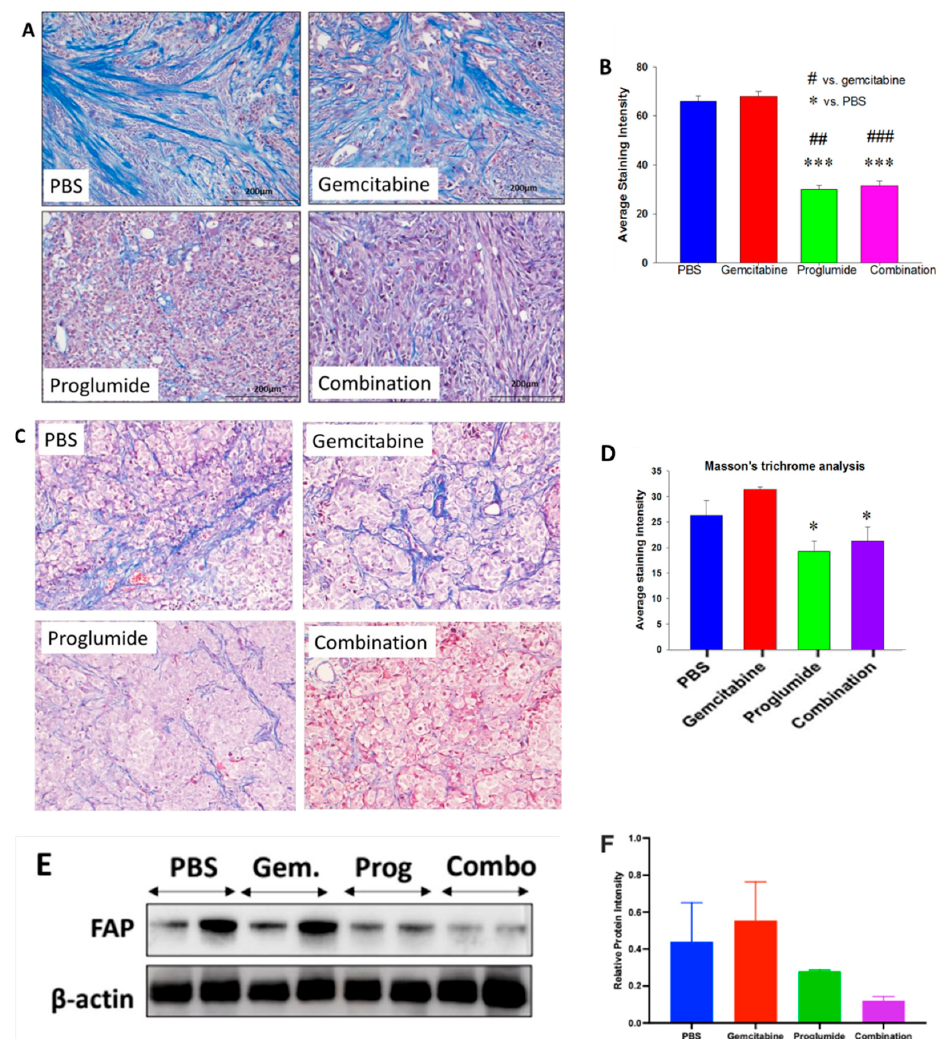
Figure 2. CCK receptor inhibition with proglumide decreases fibrosis in the pancreatic TME. ( A ) Representative images from each treatment group of tumors from the mT3-2D subcutaneous murine pancreatic cancer reacted with Masson’s trichrome stain to demonstrate fibrosis in the pancreatic tumor microenvironment. Images shown are at magnification 10× (bar = 200 µm). ( B ) Quantitative analysis of fibrosis for the murine syngeneic mT3-2D tumors was determined by ImageJ. Mean ± SEM from n > 50 images. Significantly less fibrosis was detected in the proglumide and combination-treated tumors ( # compared to gemcitabine, * compared to PBS controls; ## p < 0.005, *** p < 0.005, ### p < 0.001). ( C ) Representative images from each treatment group of PANC-1 ortho- topic tumors reacted with Masson’s trichrome stain to demonstrate fibrosis in the pancreatic tumor microenvironment. Images shown are at magnification 10 × . ( D ) Quantitative analysis of fibrosis in PANC-1 tumors was determined by ImageJ. Mean ± SEM from n ≤ 50 images. Significantly less fibrosis was detected in the proglumide and combination treated tumors (* p < 0.05). ( E ) Western blot of protein from ( n = 2) representative homogenates of the mT3 = 2D tumors examining the protein expression of FAP and normalized with β -actin. (The whole western blot is shown in